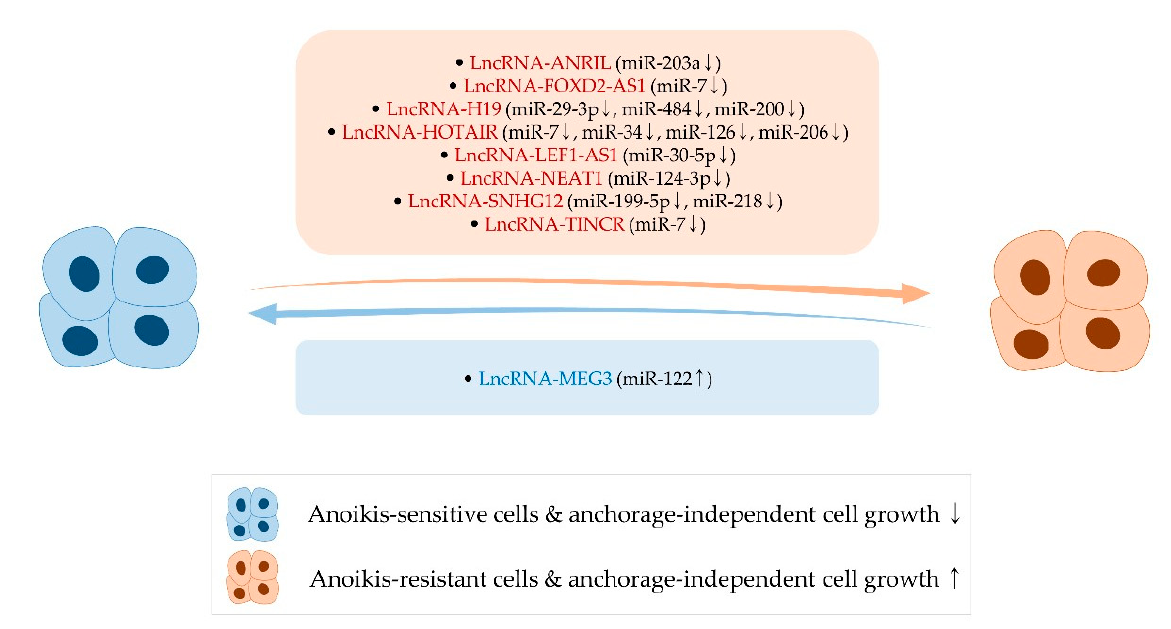
Figure 3. Oncogenic (red), tumor-suppressive (blue) lncRNAs, and miRNAs (black) that are affected by lncRNAs affecting anoikis and anchorage-independent cell growth in cancer. It is described in Table 3 and Section 4. Table 3. LncRNAs that affect the anoikis resistance and anchorage-independent cell growth in cancer.